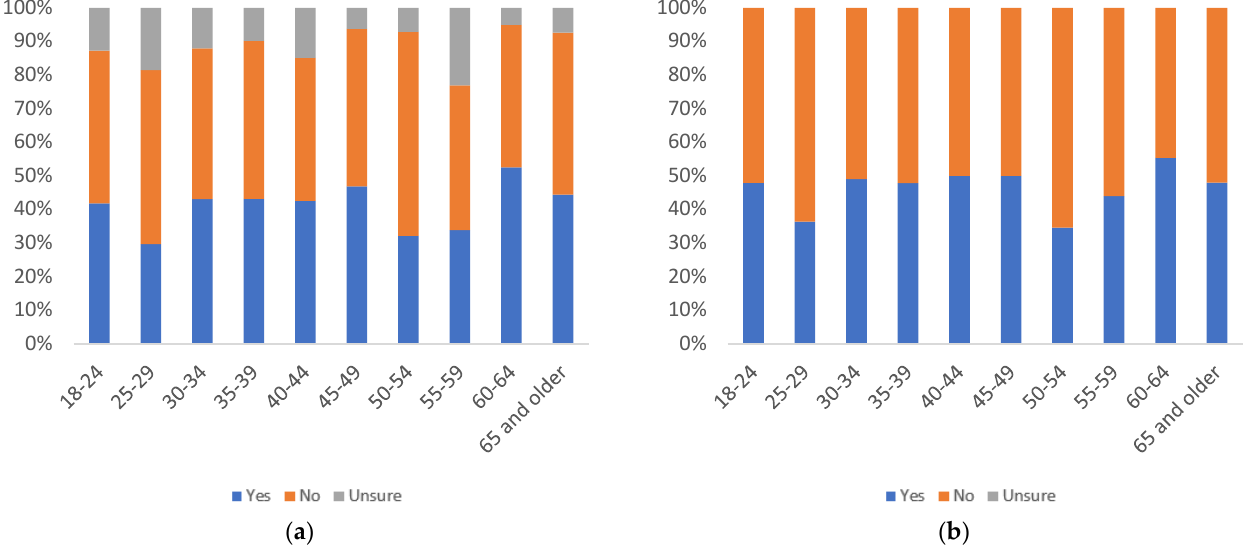
Figure 8. Label annoyingness, by age group: ( a ) with uncertain respondents (left) and ( b ) without uncertain respondents (right).